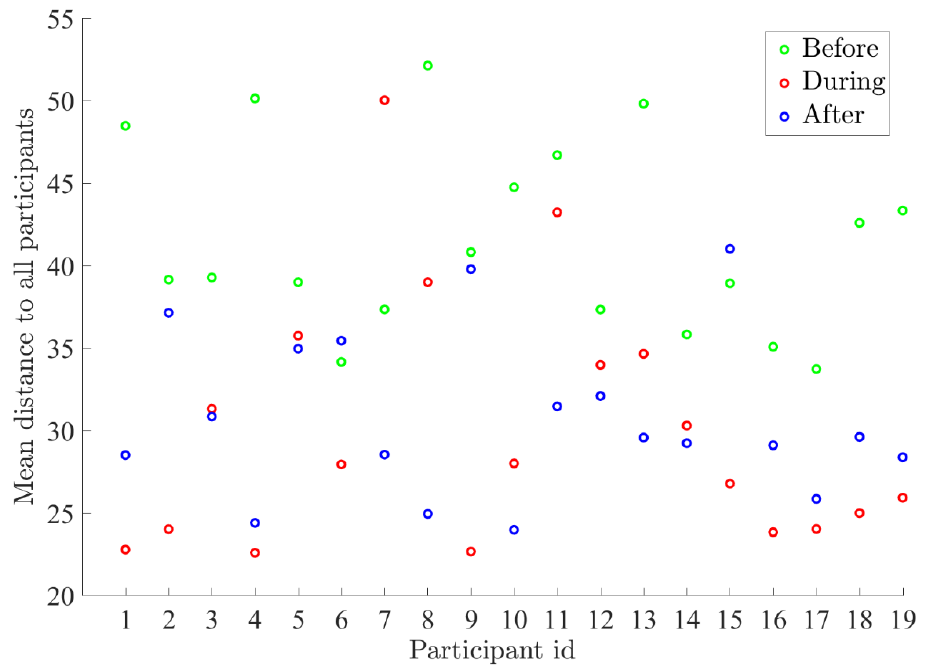
Figure A7. Pairwise synchronization for New Zealand’s group. For the majority of participants (18 out of 19) the mean Euclidean distance during the HLI was smaller than before the HLI, indicating that those participants were more coherent with the group during the HLI than they were before. The mean distance after the HLI is also smaller (for the majority of participants) than before the Heart